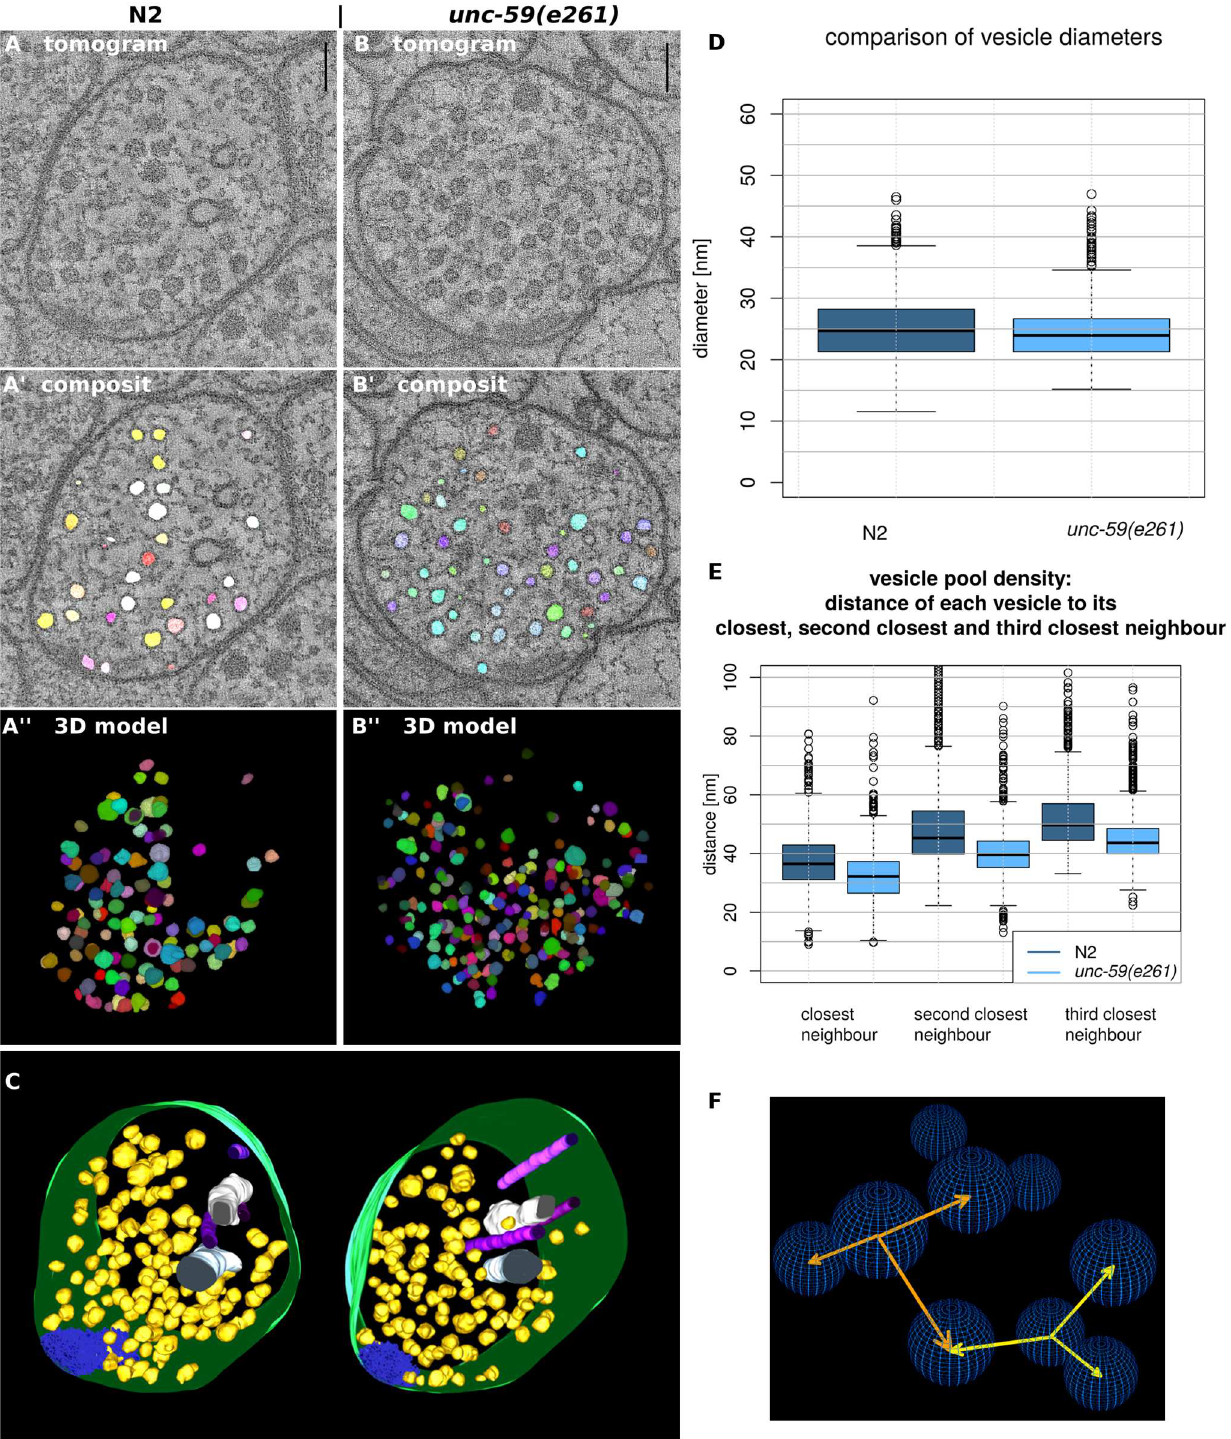
Fig 4. Comparison of N2 and unc-59(e261) C . elegans tomograms using 3D ART VeSElecT. Fig 4 shows steps of vesicle annotationusing 3D ART VeSElecT on N2 (A-A”) and unc-59(e261) (B-B”) C . elegans tomograms. In (A, B) the initial tomogram is illustrated, (A’, B’) show